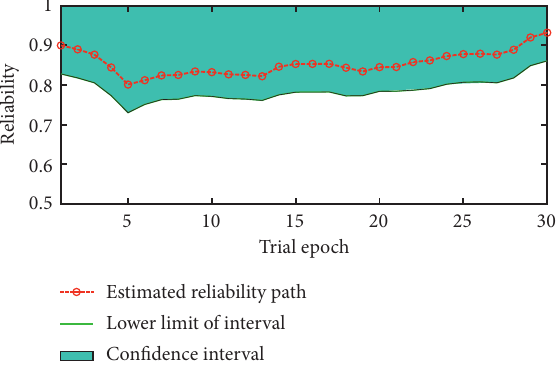
Figure 6: Estimated reliability interval for each trial.